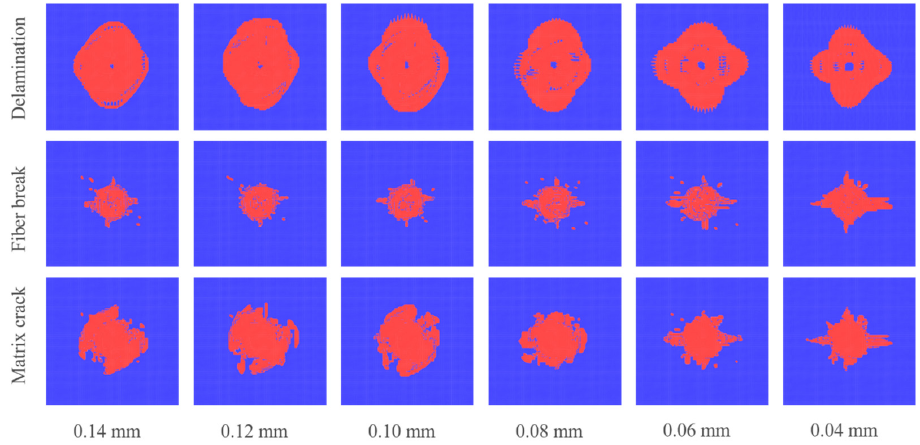
Figure 19. Comparison of impact damage with different single ply thicknesses.